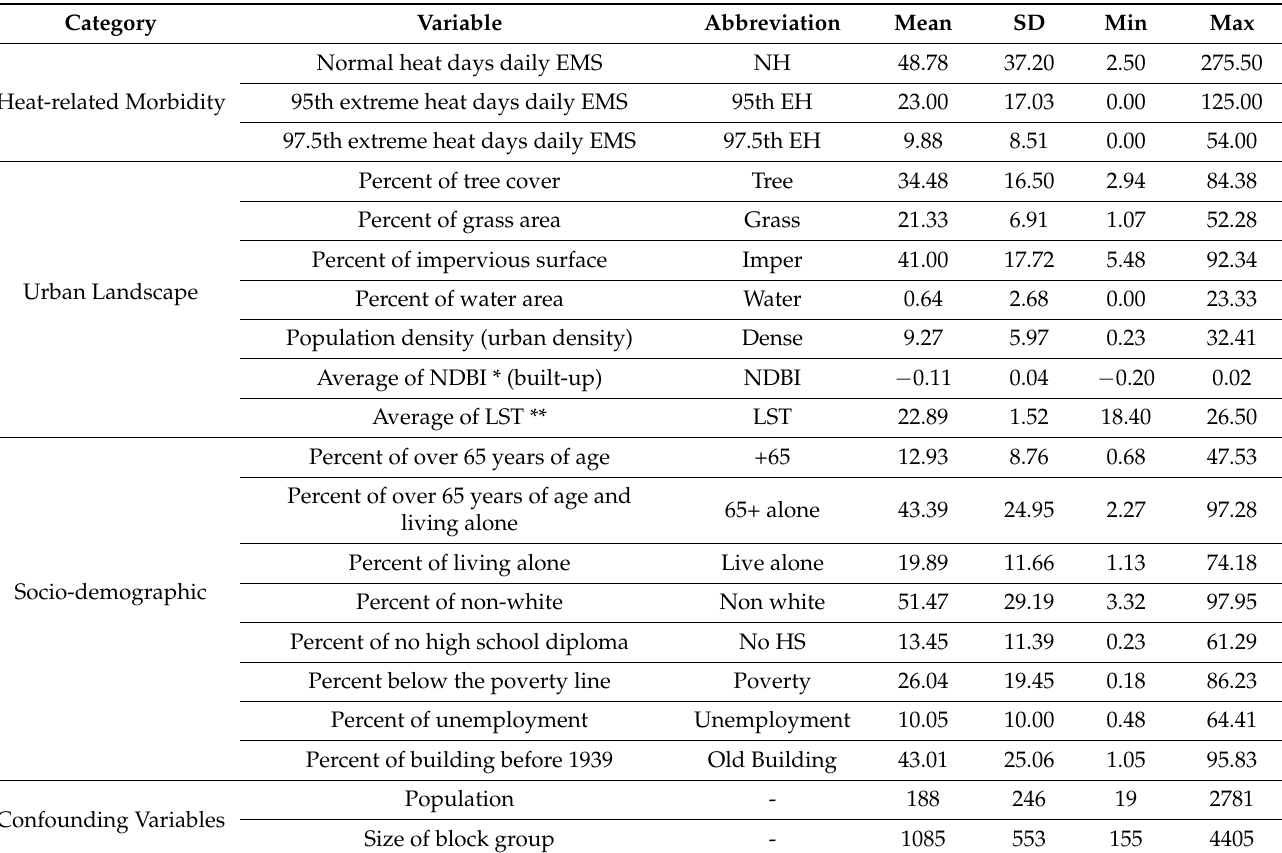
Table 1. Descriptive Statistics for census block group